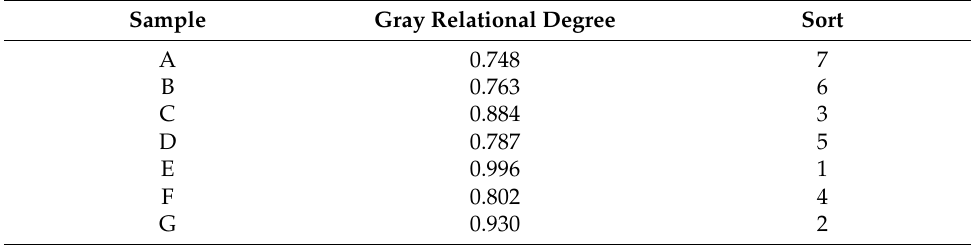
Table 5. Gray relational analysis results for each